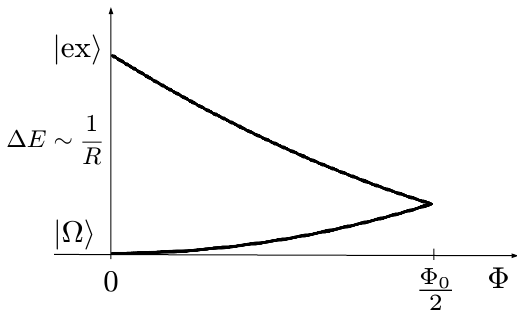
Figure 4 . Kramers degeneracy at half